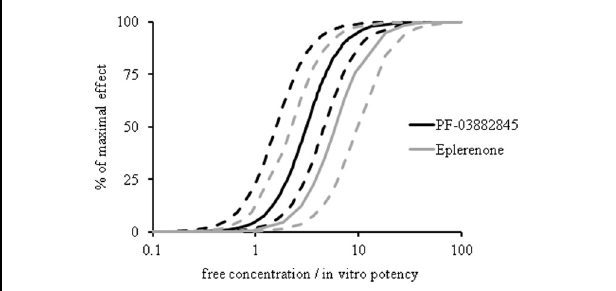
FIGURE 7 | Effect of eplerenone and PF-03882845 on urinary Na + /K + ratio. SD rats received single doses of 0, 5, 30, or 3.0mg/kg eplerenone or 0, 3, 10, or 30mg/kg PF-03882845 and urinary Na + /K + was assessed at 0–2, 2–4, and 4–7h post-dose. Both compounds yielded analogous concentration-effect curves for urinary Na + /K + . Data were expressed as free concentration normalized to in vitro IC50 (0.75nM for PF-03882845 and 109nM for eplerenone in a serum free assay). Data were modeled using an indirect response model. Dashed lines indicate the 95% lower and upper confidence boundary